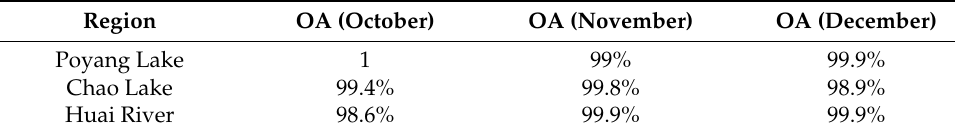
Table 2. Overall accuracies of the recovery